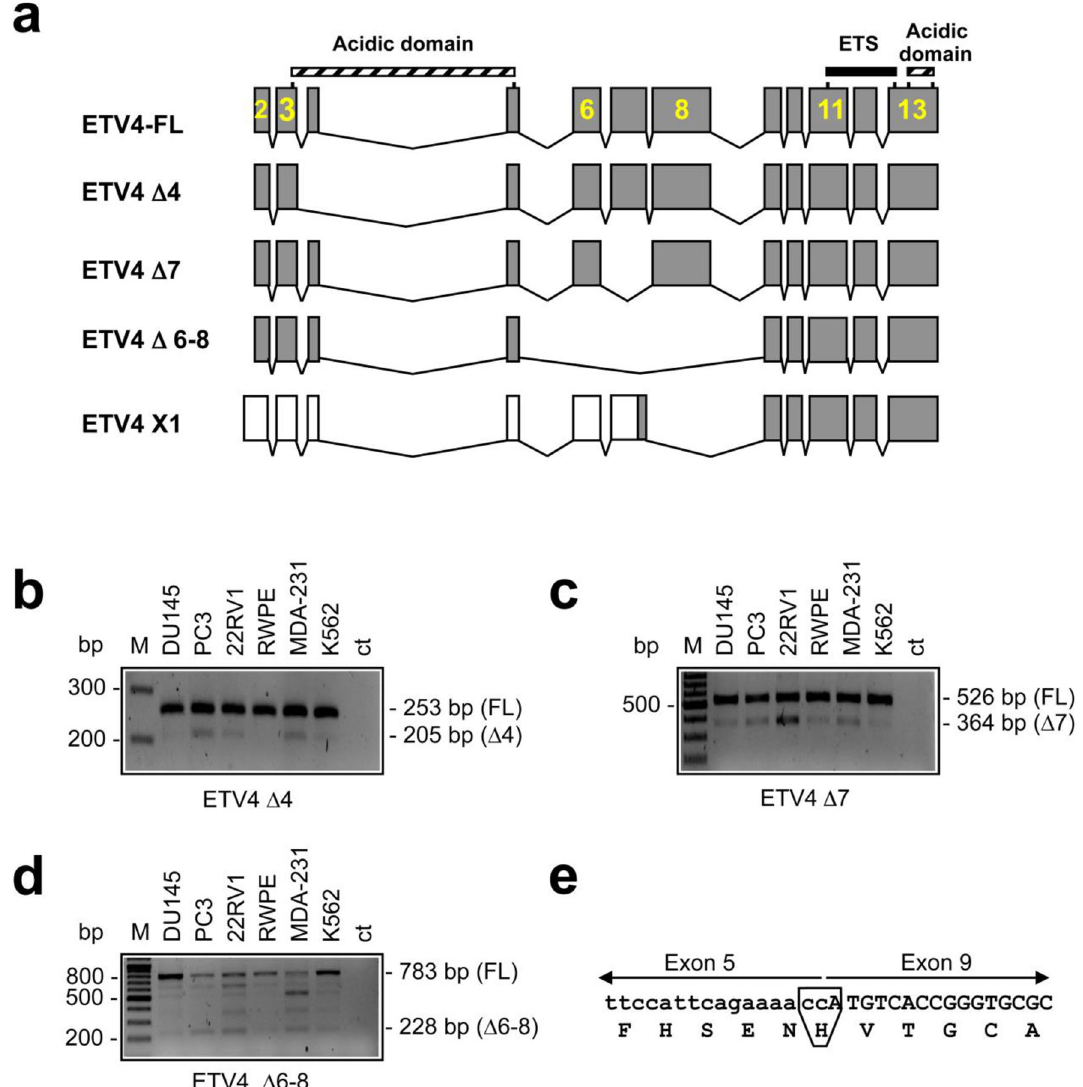
Figure 3. Detection of the novel ETV4 alternative transcripts in selected cell lines (Du145, PC3, 22RV1, RWPE, MDA-231 and K562). ( a ) Schematic representation of the potentially productive splice transcripts of ETV4 found by cloning and sequencing in PC3 and Du145 cell lines. The exon structure is shown with coding exon sequences in grey and 5’ UTRs in white. The position of functional features is shown at the top: DNA-binding ETS motif (black bar); Acidic domain (hatched bars). The structure of the full-length ETV4 ( ETV4 FL) and of the short X1 transcript ( ETV4 X1) are reported for comparison. ETV4 ∆4, deletion of exon 4; ETV4 ∆7, deletion of exon 7; ETV4 ∆6–8, deletion of exons 6, 7 and 8. ( b-d ) Specific RT-PCR for detection of the novel alternative transcripts of ETV4 in cell lines. Primer sequences for the specific amplification of each alternative transcript are reported in Supplementary Table 1. Lane M is the 100 bp ladder. Sizes of the expected bands are reported on the right. In each panel the larger band is from the long ETV4 transcripts ( ETV4 -FL), the smaller from ETV4 ∆4 ( b ), from ETV4 ∆7 ( c ) and from ETV4 ∆6–8 ( d ). In panel ( d ) are present additional bands including the 621 bp ( ETV4 ∆7) and the 517 bp ( ETV4 X1) amplicons. ( e ) Nucleotides present at junction in the ETV4 ∆6–8 variant. The amino acids present at the junction are also reported. In the box is shown the amino acid substitution presents in the variant in respect to the full-length ETV4 . Exon numbering is according to the ETV4 genomic sequence NC_000017.11 based on the GRCh38.p13 Primary